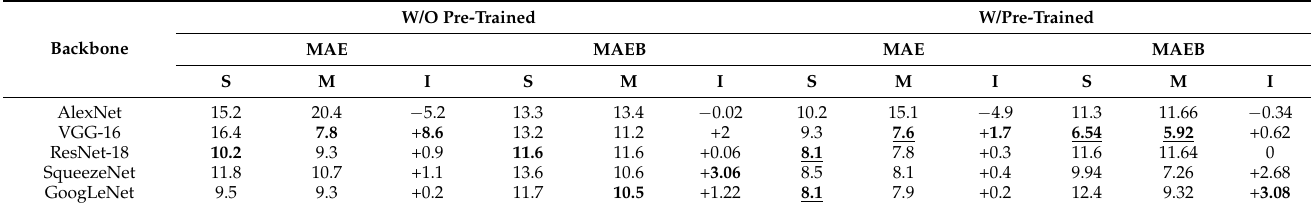
Table 2. Performance comparison between the baseline (single-task, abbreviated as S) and the proposed multitask learning models (abbreviated as M) on the synthesized test set. The column “I” indicates the improvement achieved by applying multi-task